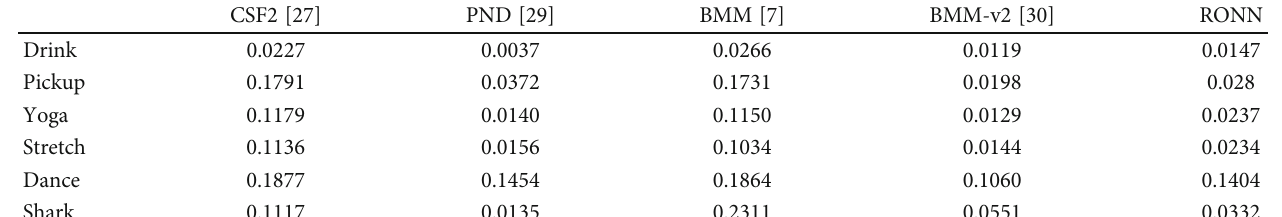
Table 7: e for the sparse dataset. 3 D